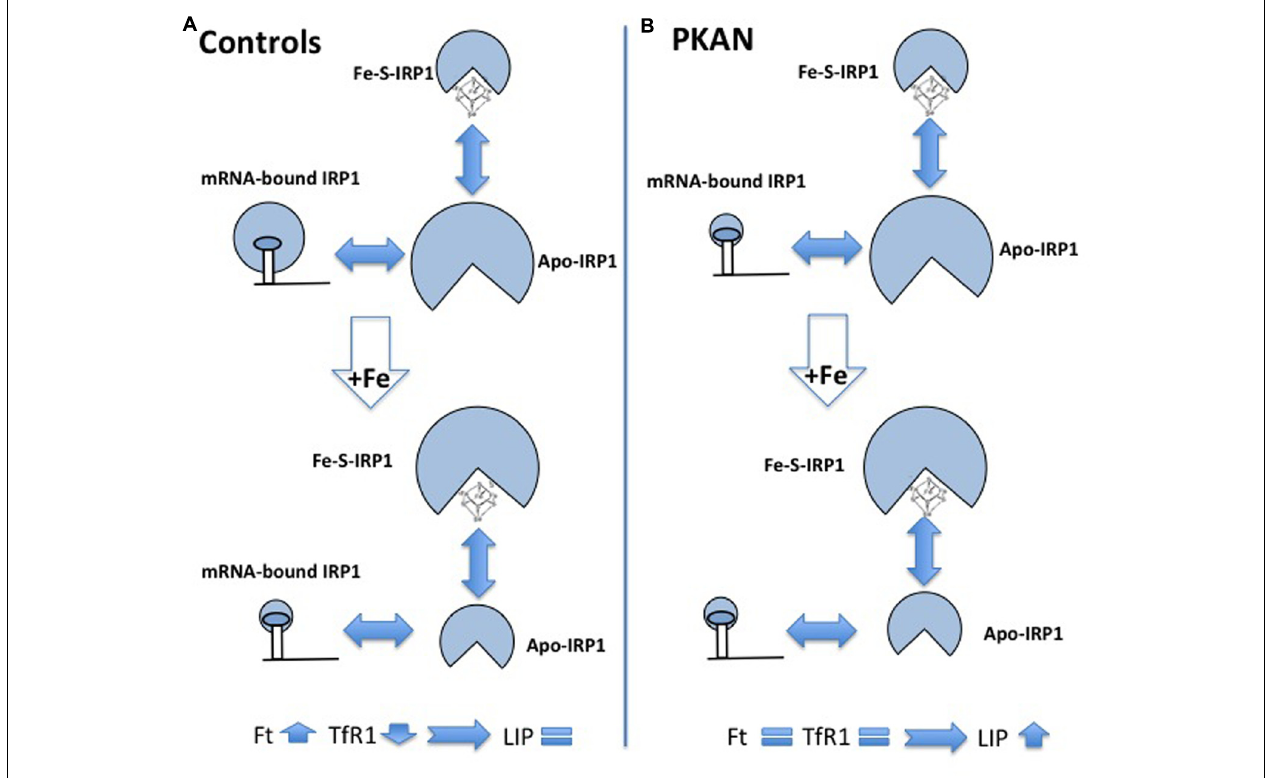
PKAN than in controls fibroblasts. Controls cells respond to iron addition, reducing the amount of mRNA-bound IRP1 and leading to up-regulation of ferritin (Ft) and down-regulation of transferrin receptor 1 (TfR1).This does not occur in PKAN cells where the levels of Ft andTfR1 do not change allowing free iron